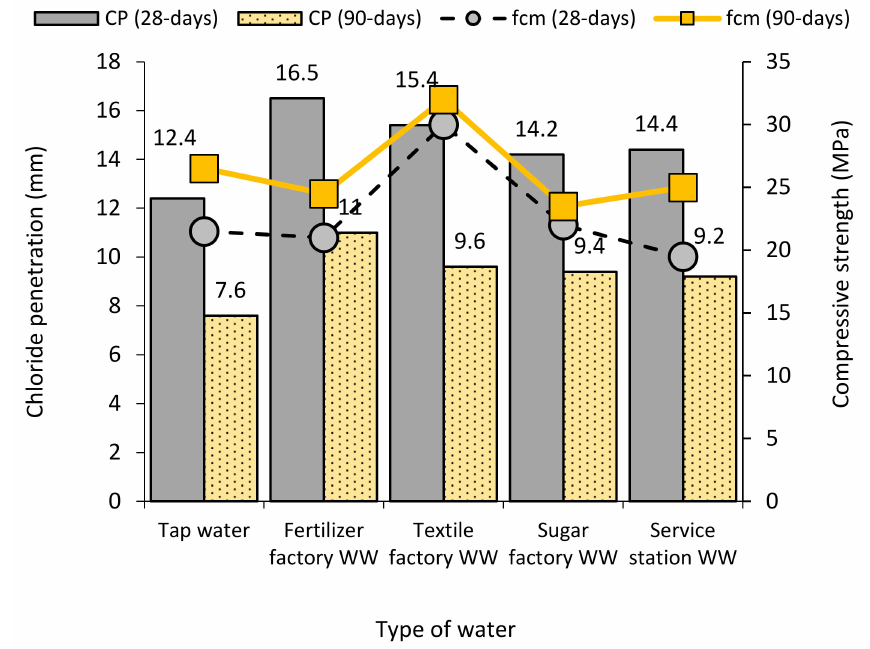
Figure 20. Chloride ion penetration of concrete made with different types of